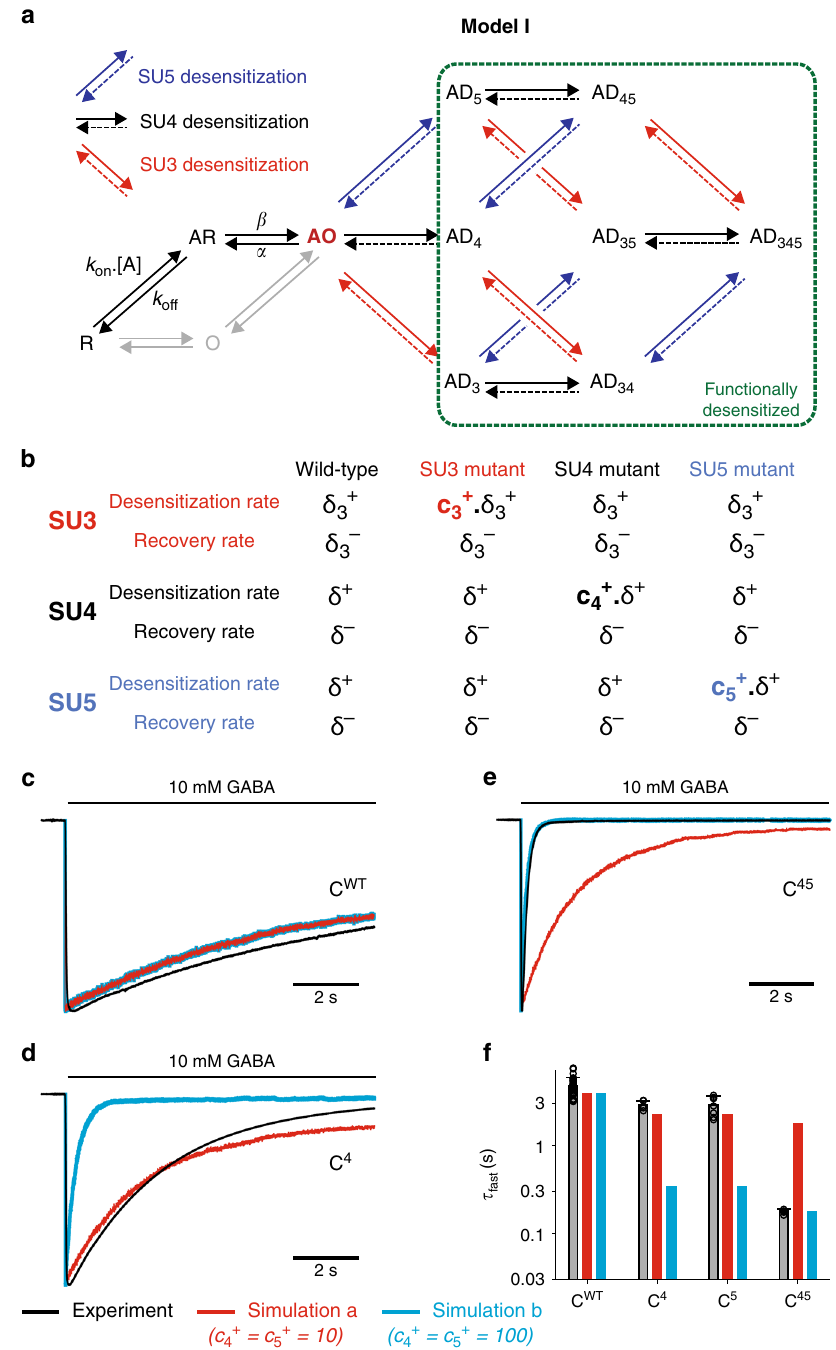
Fig. 4 Model I: only the fully open state is conducting, and subunits move independently during desensitization. a We assume in this model that a single desensitized subunit is enough to shut the pore of the channel, leading to functional desensitization. Moreover, subunits SU3, SU4, and SU5 can undergo a desensitization rearrangement independent of the other subunits. Thus, desensitization rates ( δ 3 + for SU3, δ + for SU4 and SU5) and recovery rates ( δ 3 − for SU3, δ − for SU4 and SU5) do not depend on the conformation of the neighboring subunits. b Effect of M3-5 ′ valine mutations in Model I. Mutations are hypothesized to speci fi cally increase the desensitization rates of the mutated subunits, without altering any other parameter. c – e Representative currents for C WT (panel c ), C 4 (panel d ) and C 45 (panel e ), in black, are compared to the outcome of two distinct simulations. In simulation a (red), the mutation-induced increase in the desensitization rates of SU4 and SU5 is adjusted so that the simulation of single mutants C 4 and C 5 broadly fi ts the experimental data, as seen in panel ( d ). In simulation b (blue), the mutation-induced increase in the desensitization rates of SU4 and SU5 is adjusted so that the simulation of the double mutant C 45 accounts for the experimental data, as seen in panel ( e ). f Bar graph summarizing the experimental data vs the predicted effects of SU4 and/or SU5 mutations on the kinetics of the fast desensitization component in simulations a and b . Experimental data are shown as means (bar graphs) and standard deviations (error bars), with individual data points indicated as circles. For panels c – f note that parameters from simulation a fail at describing the data for the double mutant C 45 , while parameters from simulation b largely overestimate the effect of single mutants. See Supplementary Table 1 for numerical experimental values, the number of cells and number of independent series of experiments; and Supplementary Table 3 for the numerical values of